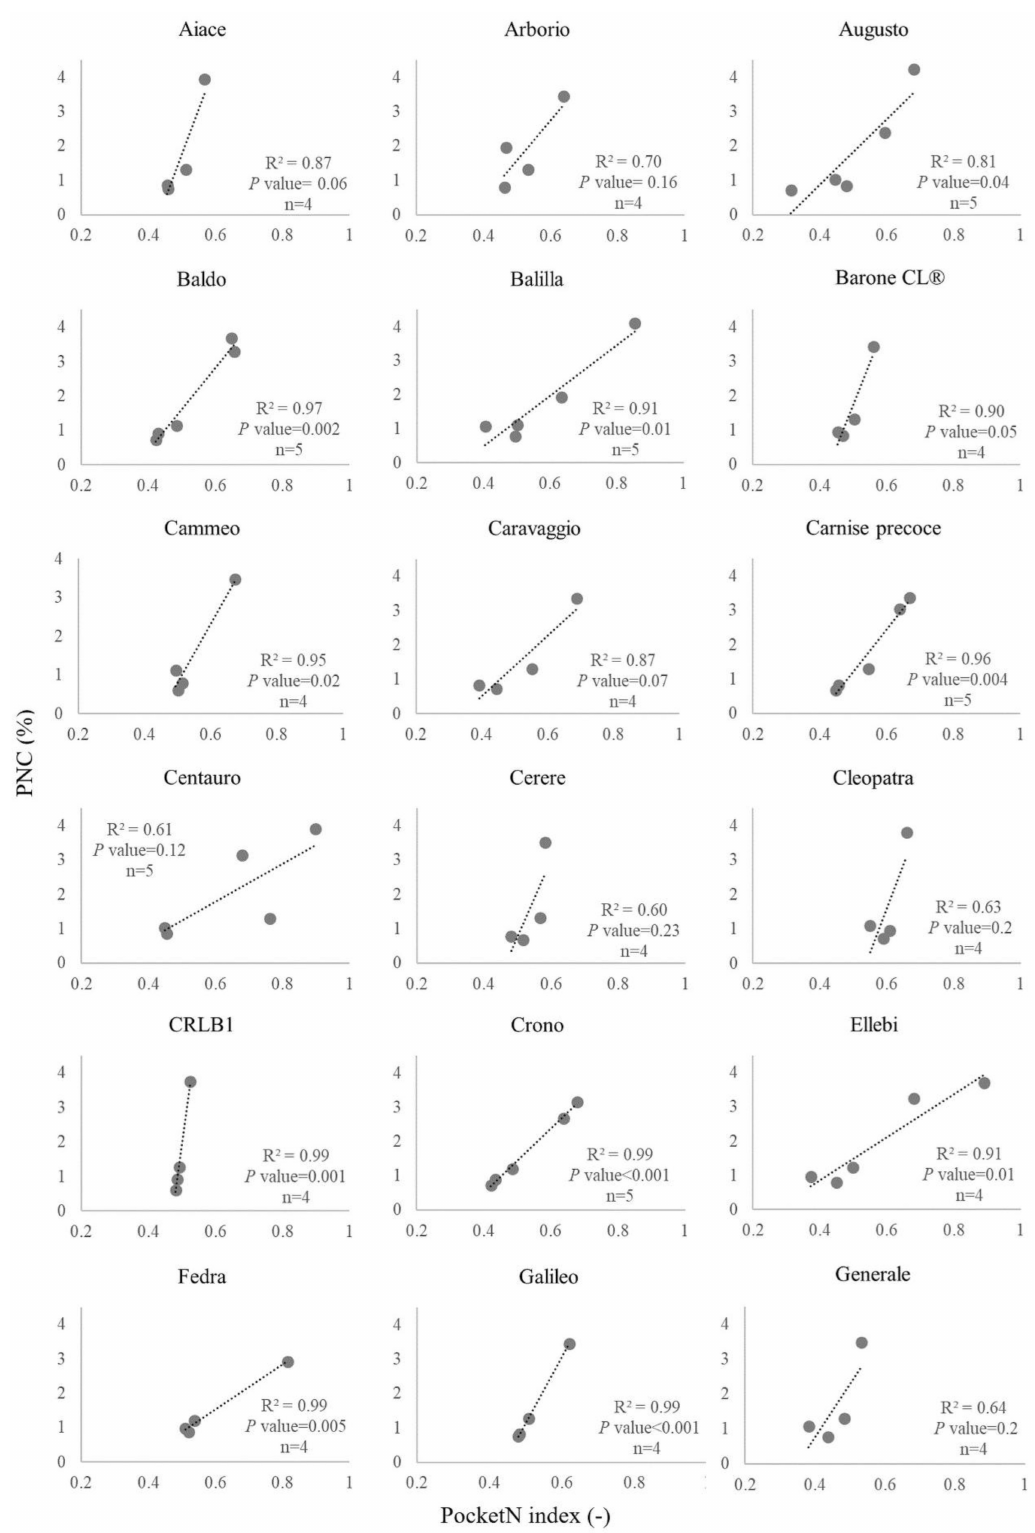
Figure A1. Relationships between the PocketN index (–) and reference plant nitrogen content (PNC) (%, from elemental analyzer) for eighteen rice cultivars included in the study. See also Table 1. These relationships were used to derive cultivar-specific calibration curves to estimate PNC using